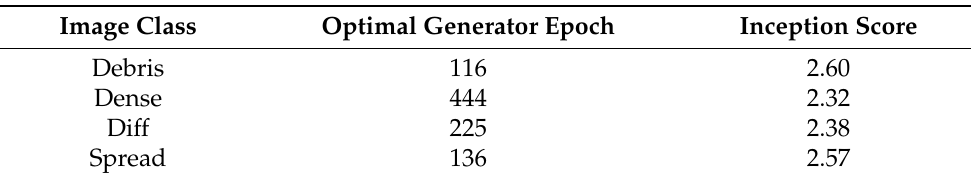
Table 6. Epoch values and corresponding inception scores at which the GAN generator is determined to be optimally trained, based on the plot of inception score vs. training epoch. Each GAN is trained on an individual class, and, therefore, requires a different level of training based on the number of images in each class, as well as complexity of features and other variables. The optimal GAN is used to generate images for each class to be used for dataset augmentation.